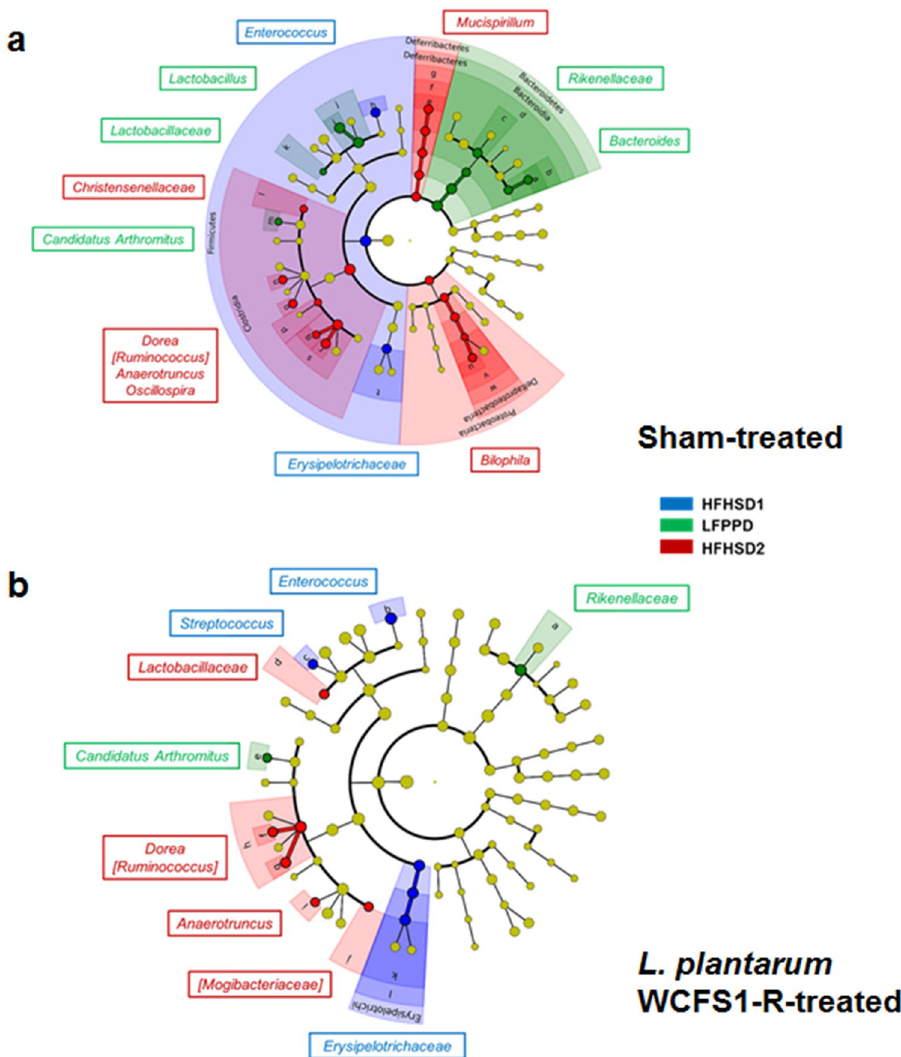
Figure 3. Taxonomic cladogram comparing the fecal microbiota response to different diets. Panel ( a ) and ( b ) correspond to the results from sham-treated and L . plantarum WCFS1-R fed mice respectively. Blue, green and red nodes are bacterial taxa significantly increased during the first HFHSD (HFHSD1), LFPPD and the second HFHSD (HFHSD2). Yellow nodes indicate non-significant changes in certain bacterial taxa in response to